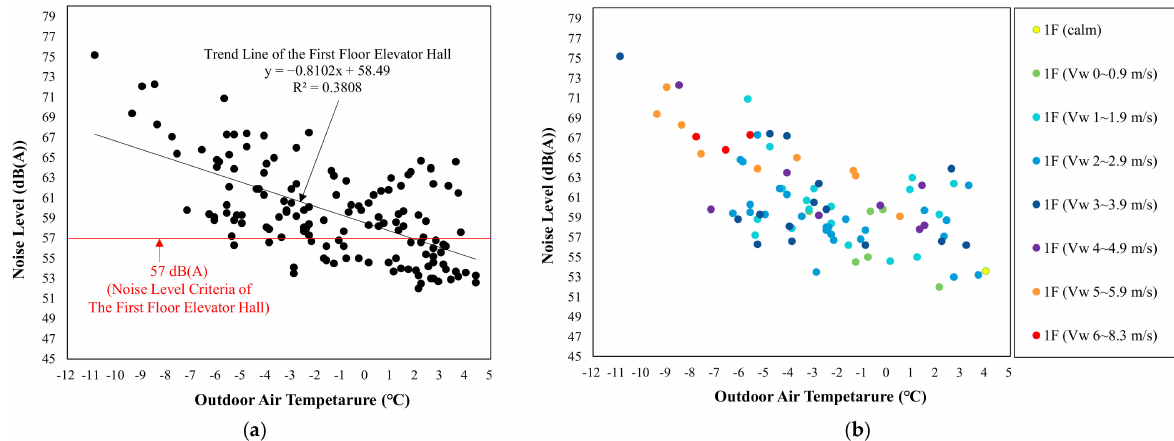
Figure 7. NL of the first-floor elevator hall is associated with both ( a ) the outdoor air temperature and ( b ) the wind velocity. Measurements were taken between 1 December 2014 and 15 February 2015, when HVAC systems are off, and the wind direction is NW, NNW,